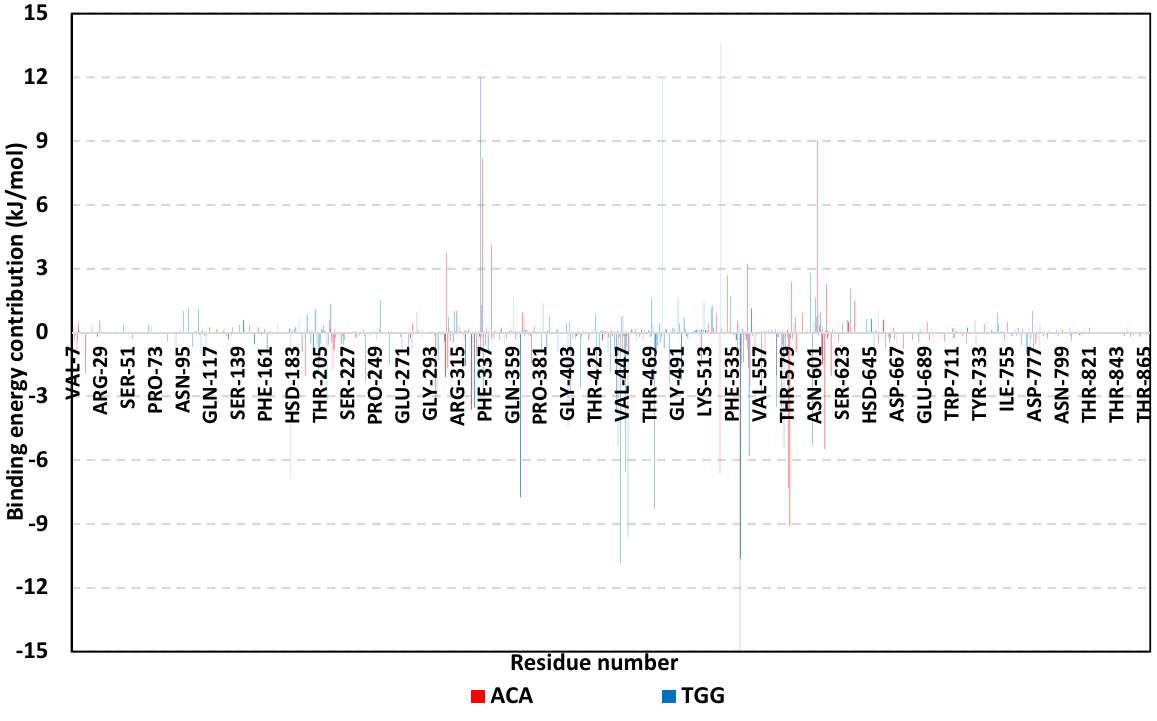
Figure 10. Residue − wise binding − free energy contributions for simulated ligand − h MGAM complexes.